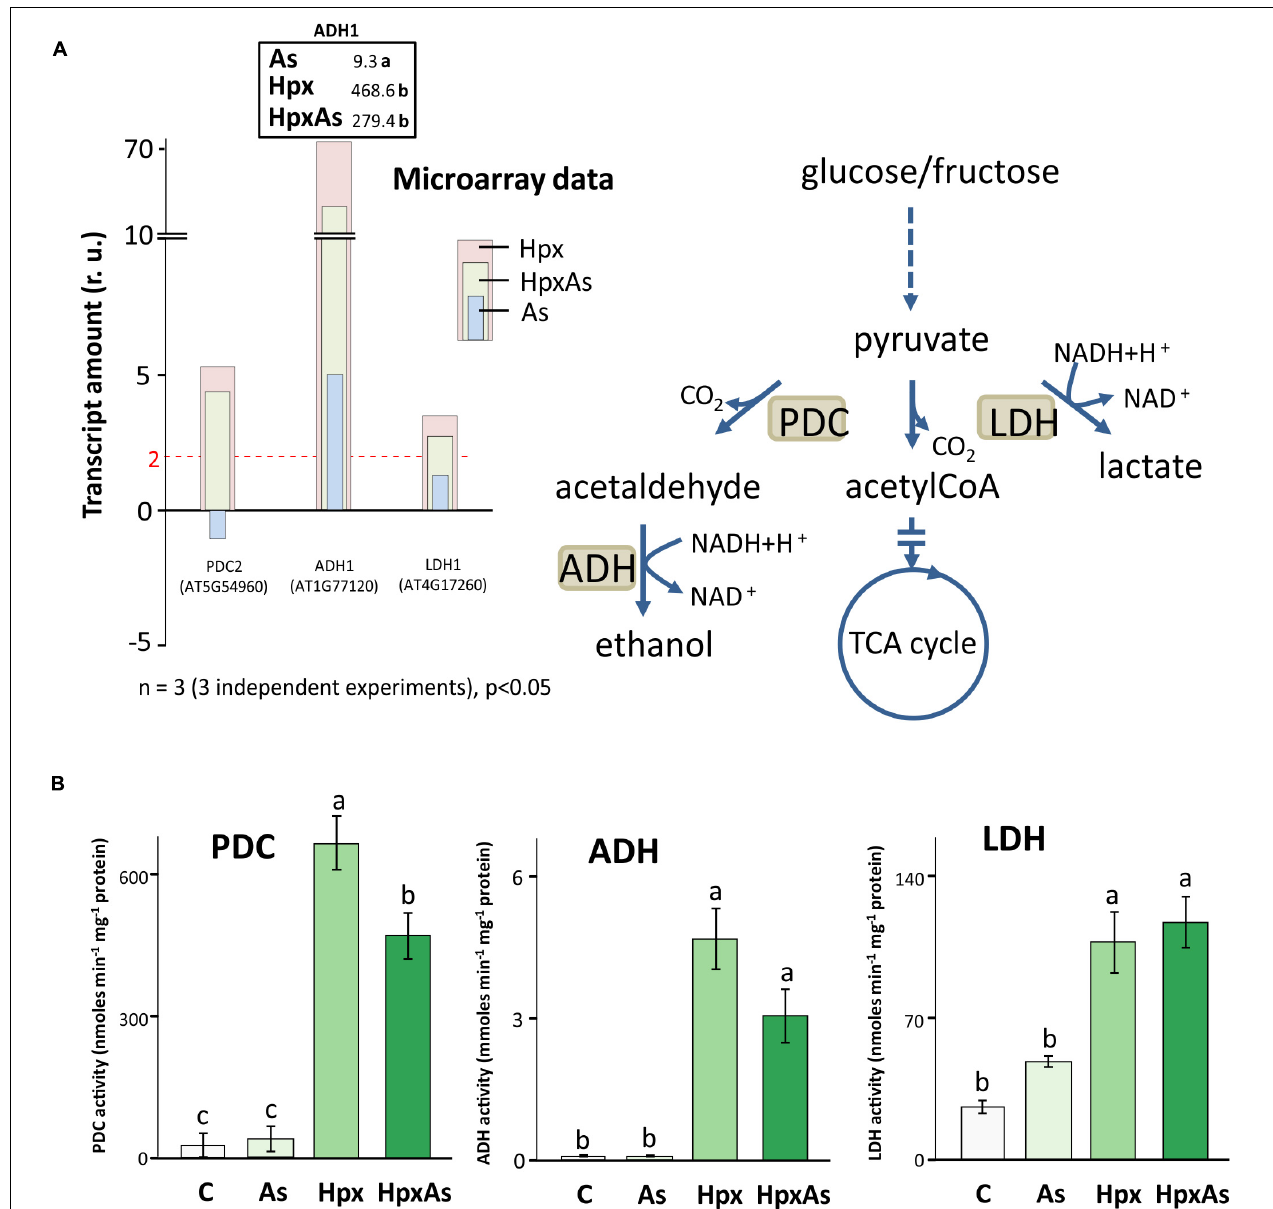
FIGURE 6 | Changes in gene expression and enzyme activity of energy metabolism-related enzymes under HpxAs compared to As and Hpx. Pyruvate decarboxylase (PDC), alcohol dehydrogenase (ADH) and lactate dehydrogenase (LDH) are crucial enzymes under anoxic conditions in ATP generation and regeneration of NAD + when the respiratory electron transport is inhibited. (A) The histogram presents relative transcript amounts of PDC2 , ADH1, and LDH1 genes after 7 days of stress application as compared to control. qRT-PCR confirmation of this transcript accumulation under given stresses is given for ADH1 on top of ADH1 bar as fold change numbers, while for several other related Hpx marker genes data are presented in Supplementary Figure 2 . Primer sequences for the qRT-PCR data are given in Supplementary Table 5 . (B) Enzyme activities for PDC, ADH, and LDH were measured spectrophotometrically in root extracts. Data display specific activity as means ± SE, n = 6 (3 independent experiments, Tukey’s test, p <